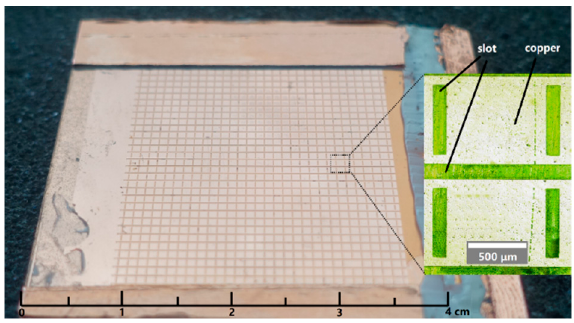
Figure 6. Photograph of the fabricated prototype.